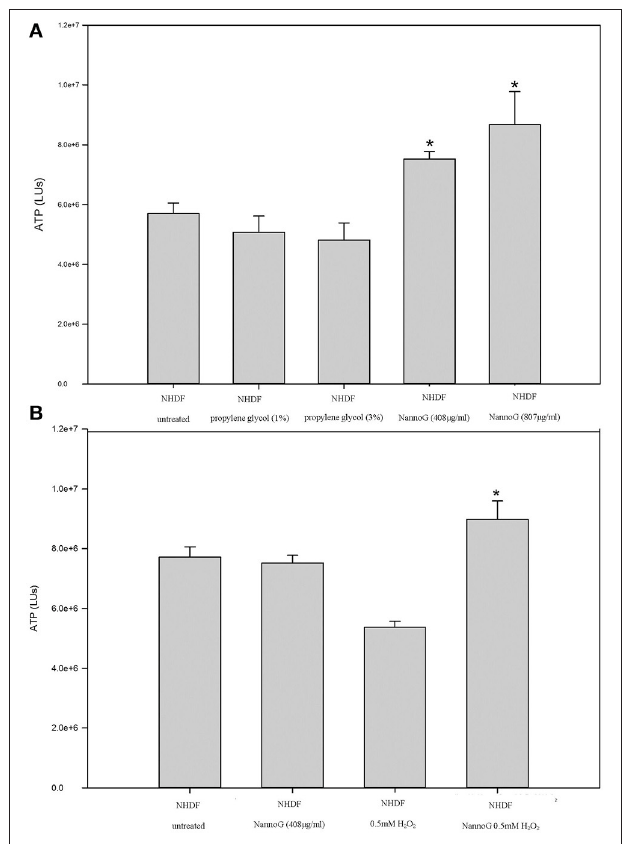
FIGURE 2 | (A) Relative ATP levels (LUs) of cells after 48 h incubation with two concentrations of propylene glycol (1, 3%) and two concentrations of NannoG (408, 870 µ g/ml). Data are expressed as mean ± SEM for 8 replicates. * p < 0.05 significantly different from the untreated cells. (B) Relative ATP levels (LUs) for untreated cells, cells treated with H 2 O 2 , cells treated with NannoG and cells treated first with NannoG and then with H 2 O 2 . Data are expressed as mean ± SEM for 8 replicates. * p < 0.05 significantly different from the control cells and cells treated with 0.5 mM H 2 O 2 .